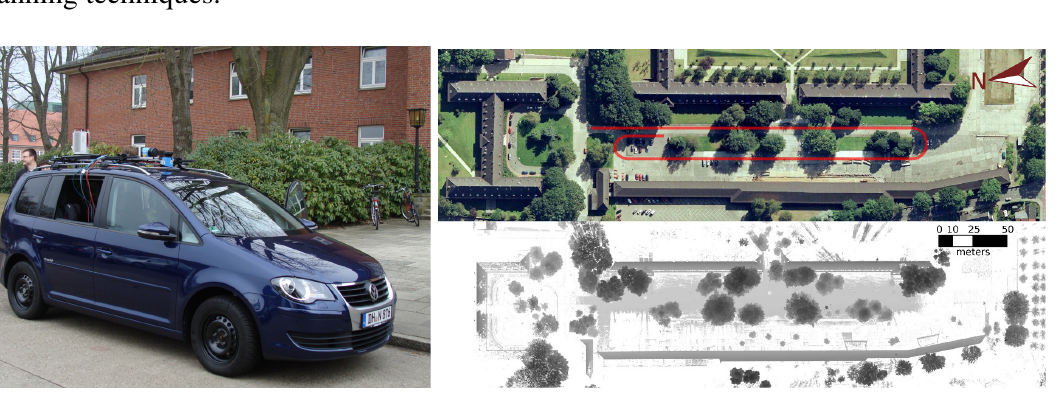
Figure 3. Campus dataset acquired at Jacobs University Bremen. ( Left ) The mobile scanner that was used to acquire the campus outdoor dataset. ( Right Top ) Digital orthophoto of the campus that has been mapped by the mobile scanner. The red line approximates the trajectory driven by the vehicle. Image courtesy of AeroWest, DigitalGlobe, GeoBasis-DE/BKG, GeoContent, GeoEye and Google. ( Right Bottom ) For comparison purposes, the environment was also modeled using standard terrestrial laser scanning techniques.